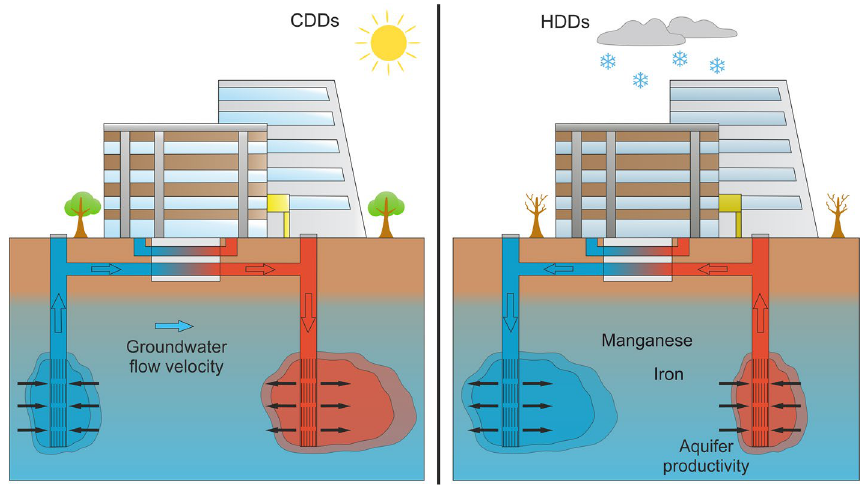
Fig. 1 Schematic operation principle of ATES in cooling mode (left) and in heating mode (right). The hydrogeological criteria aquifer productivity, iron and manganese contents in groundwater and groundwater flow velocity as well as the climatic criterion represented by cooling degree days (CDDs) and heating degree days (HDDs) are included for illustration purposes